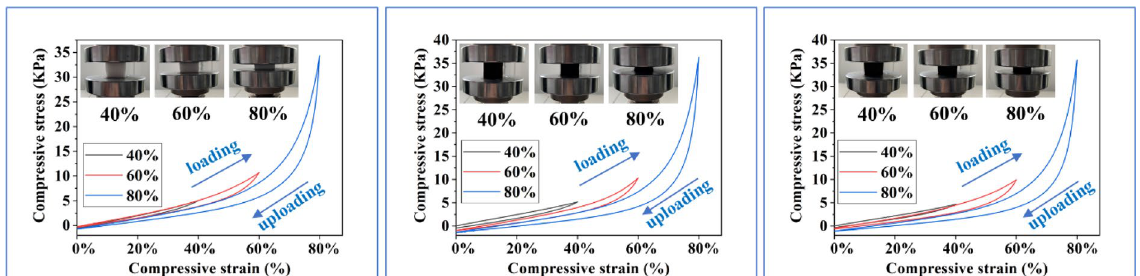
Figure 17. The stress–strain curves of the superhydrophobic MS at different strain of 40%, 60%, and 80%, respectively. ( a ) MS; ( b ) OTS-PDA-MS ( c ) OTS-PDA-MS after reused. And the Inset photographs of sponges during the compression